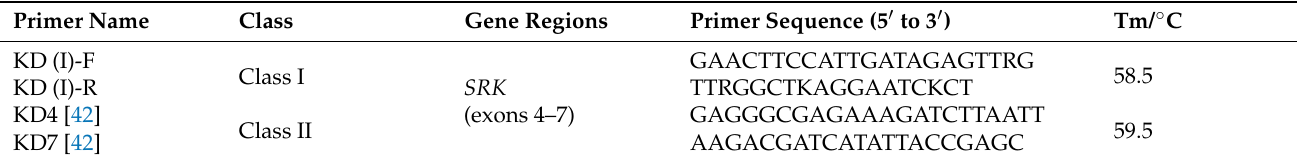
Table 8. Specific primers of SRK